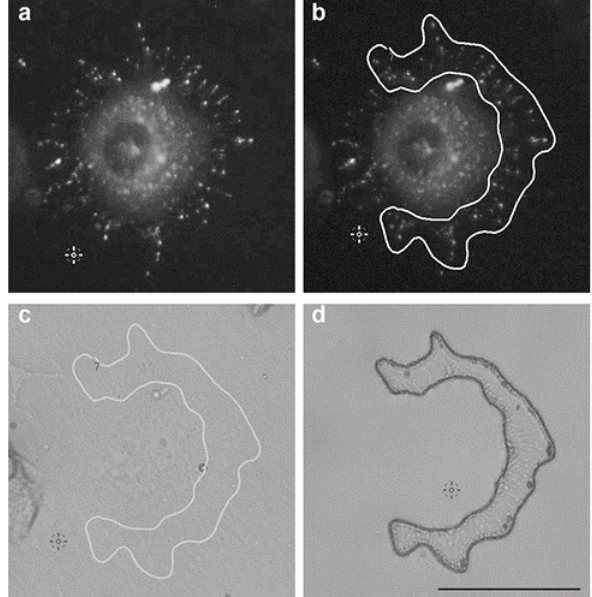
Figure 8. Isolation of GFP-Myo10 filopodia in transfected CADs using IF laser capture microscopy. ( a ) Representative image of a GFP-Myo10 transfected CAD cell by IF, ( b ) ROI drawn around GFP-Myo10 positive filopodia using fluorescence settings or ( c ) using the phase contrast settings. ( d ) LCM isolated filopodia after removal of unwanted cells. (Scale bar = 50 µ